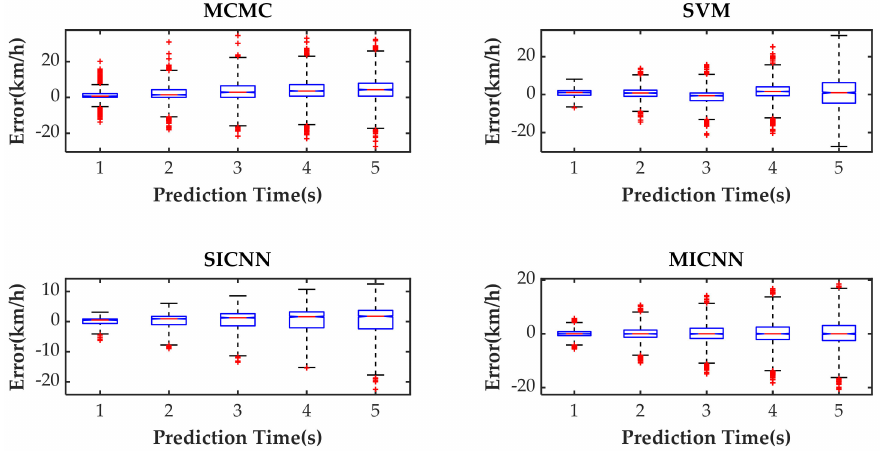
Figure 12. The box plots of the prediction